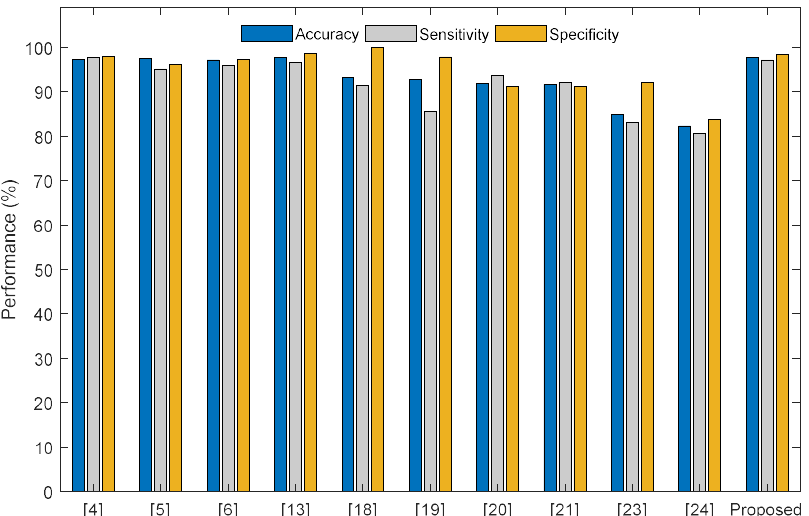
Figure 13. Validation of the disease detection accuracy of the proposed system with existing ap- proaches.